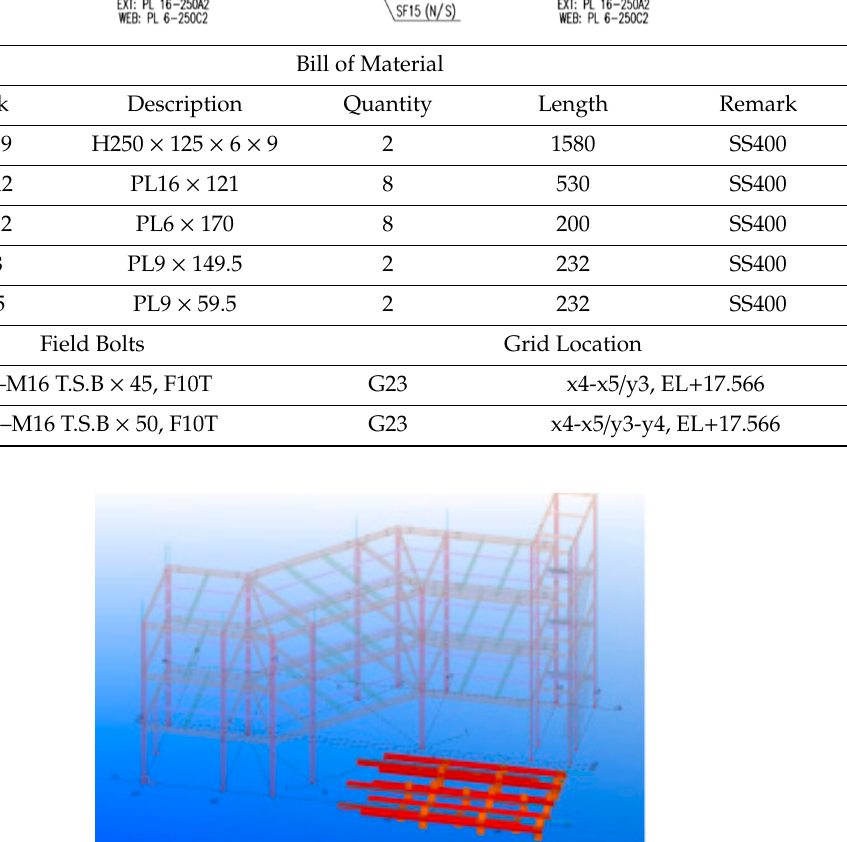
Figure 7. Preliminary review of building and member laydown area.